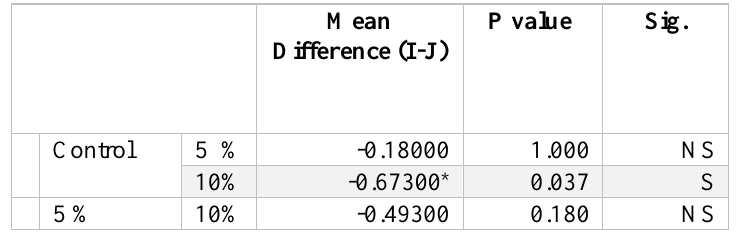
Table 4: Bonfferoni multiple comparisons test of immersion part